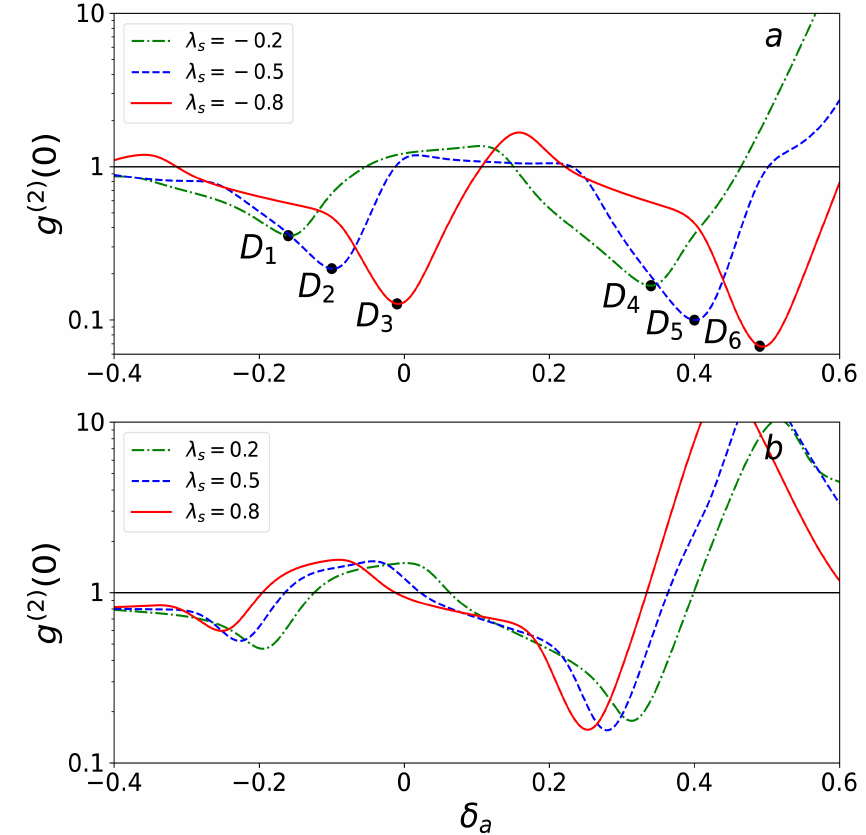
Figure 3. The equal-time SOC function g ( 2 ) ( 0 ) of the cavity field versus the driving detuning δ a for various values of the BEC internal interaction strength λ s : ( a ) λ s = − 0.8 (red solid line), λ s = − 0.5 (blue dashed line), λ s = − 0.2 (green dotdashed line) and ( b ) λ s = 0.8 (red solid line), λ s = 0.5 (blue dashed line), λ s = 0.2 (green dotdashed line). Other parameters are C e = C g = √ 1, λ iC = 0.08, λ CB = 2/2, λ iB = 1, η = 0.01, γ c = 0.1 in units of Ω b